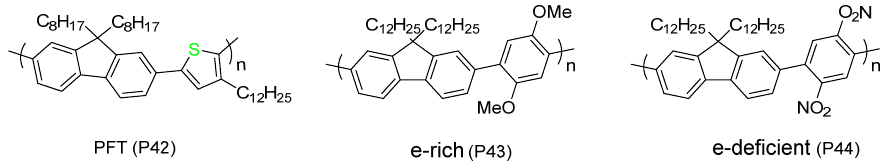
Figure 9. The polymers used for exploring the effect of electronic structure on selectivity.